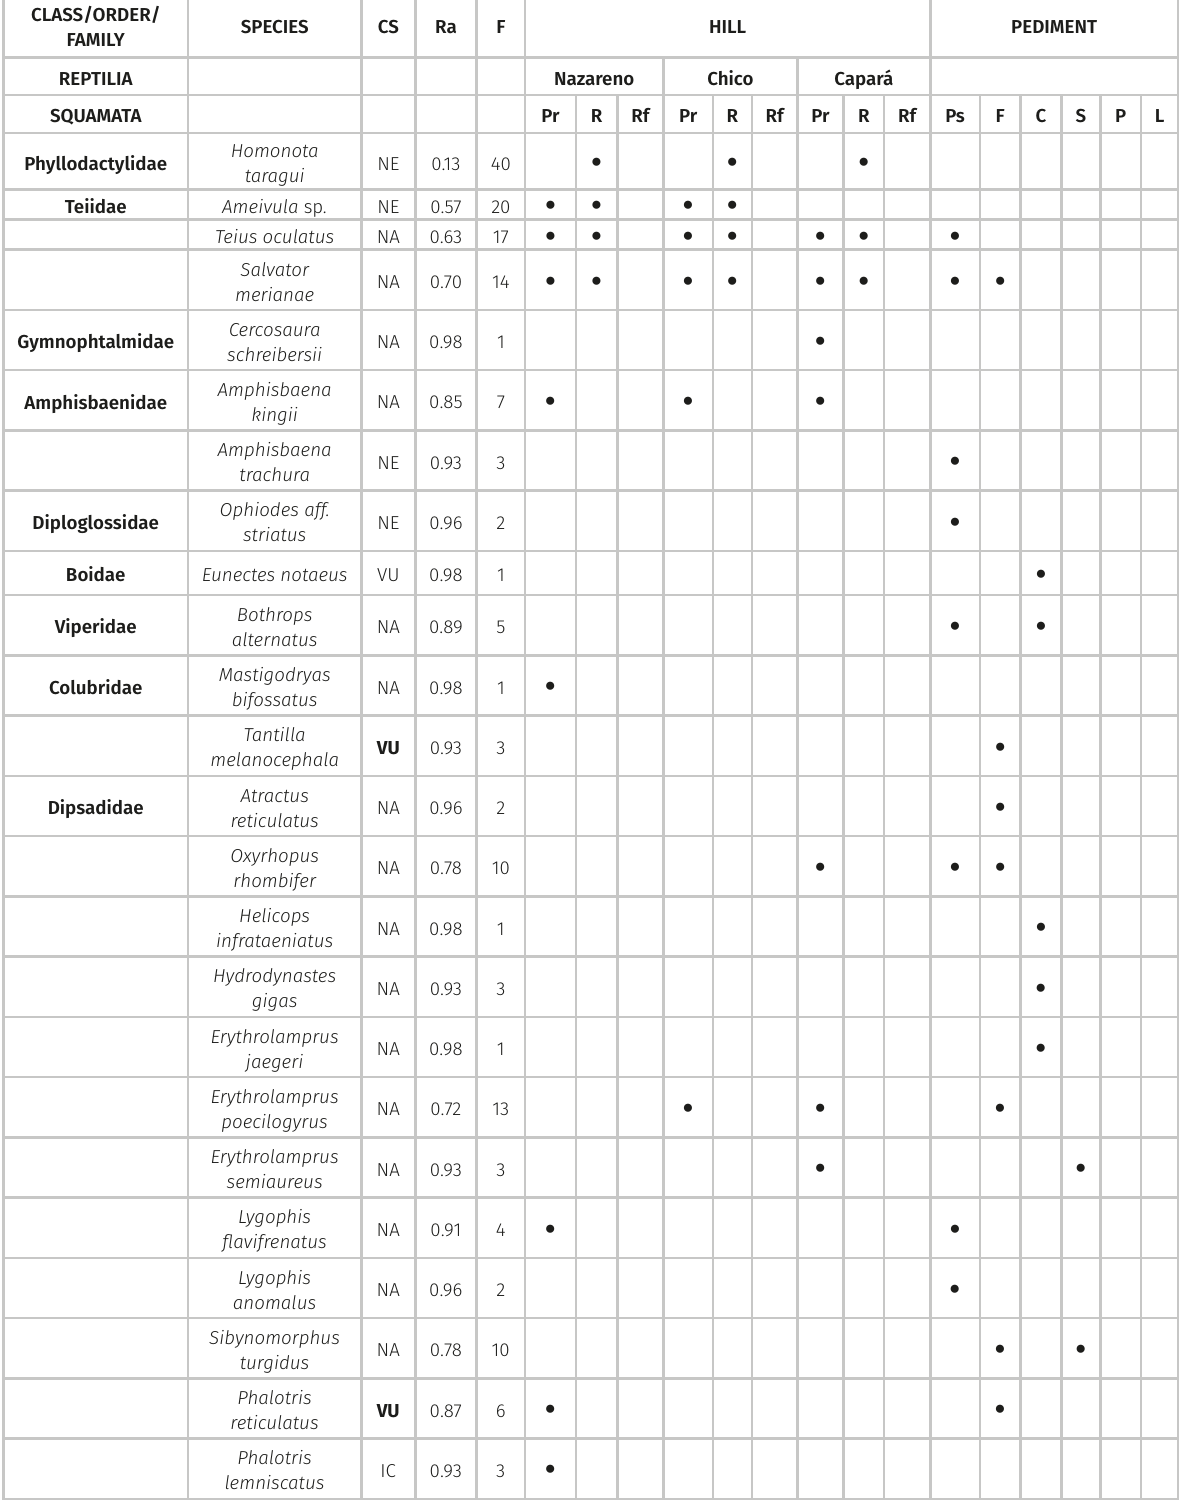
Table I. CLASS/ORDER/ FAMILY REPTILIA SQUAMATA Phyllodactylidae Teiidae